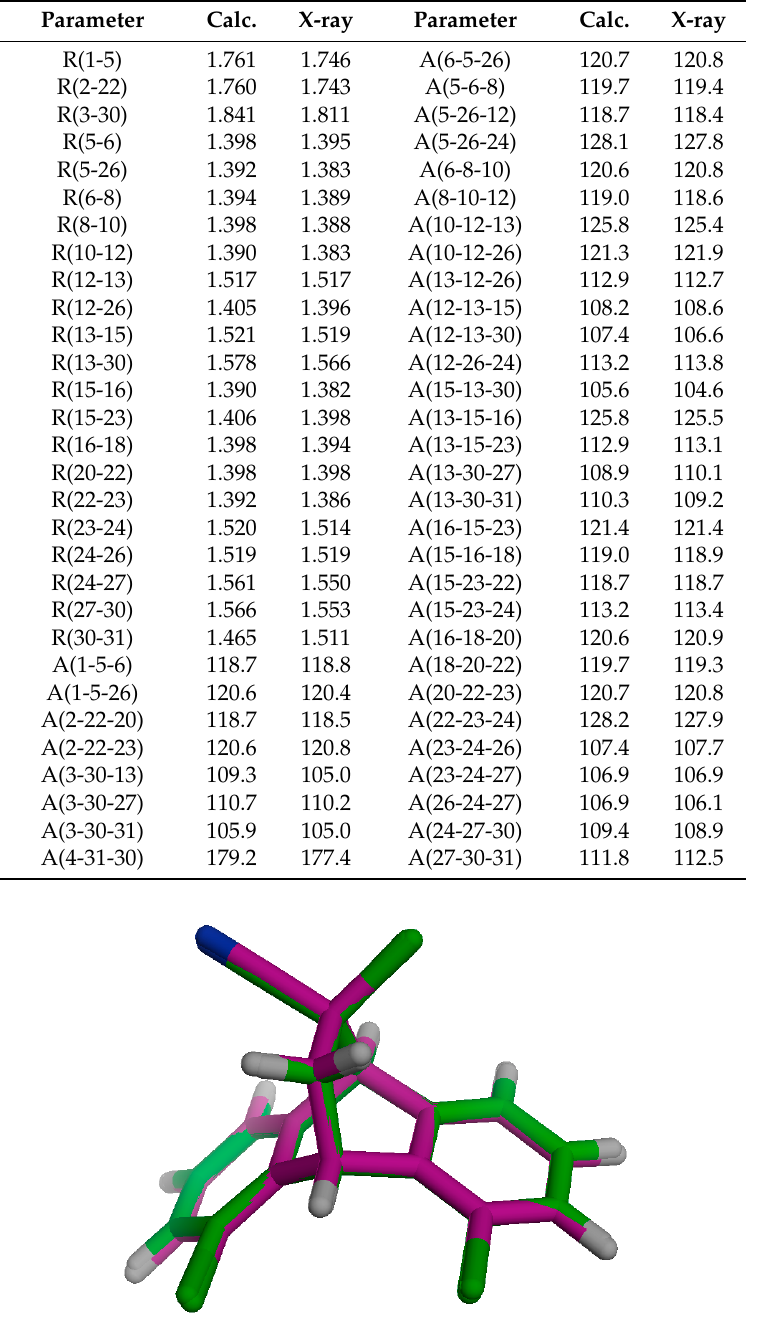
Table 3. Calculated and experimental bond distances (Å) and angles (°) of isomer 1. Parameter Calc.